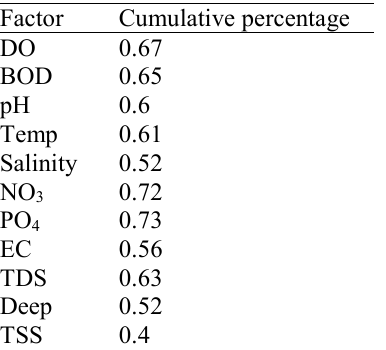
Table 2. Results of PCA regarding reduction of physicochemical parameters of water in Choghakhor wetland, Iran (2017-2018) Cumulative Percentage Component Total variance of variance Table 3. Output of cumulative rate of physicochemical parameters of water in Choghakhor wetland